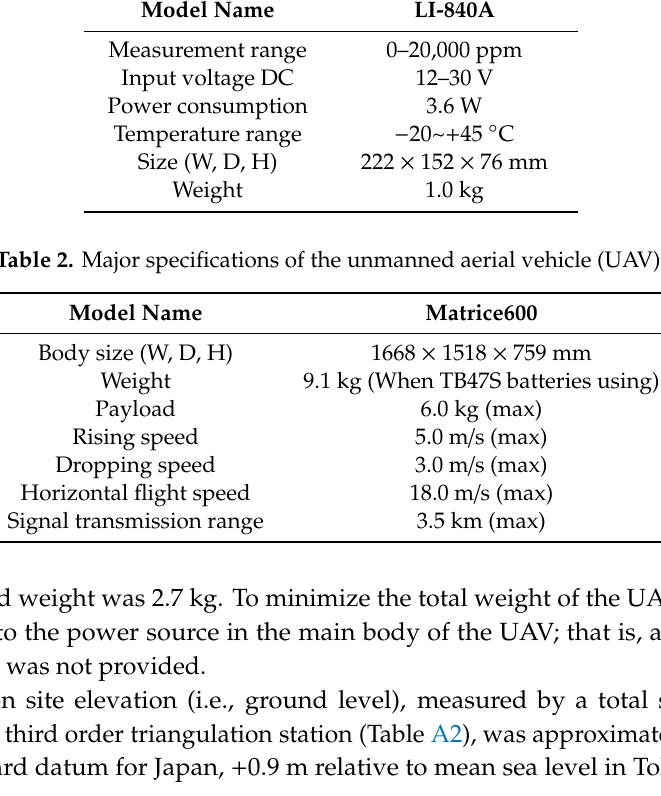
Table 1. Major specifications of the non-dispersive infrared (NDIR) analyzer.